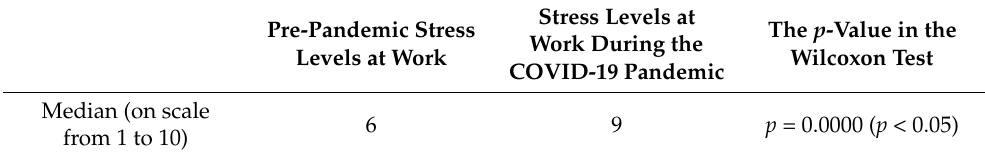
Table 3. Comparing the median in two dependent groups by Wilcoxon